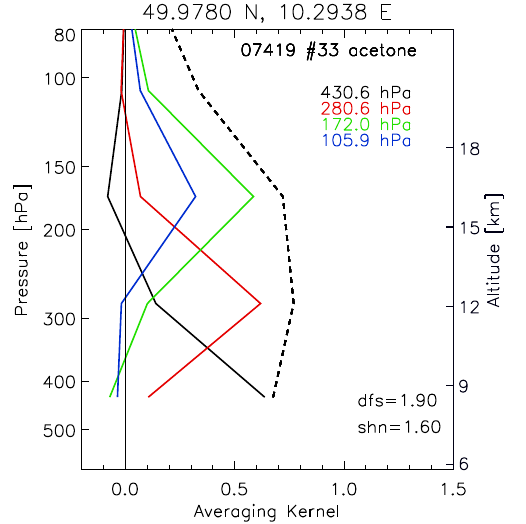
Fig. 3. A representative averaging kernel in log(VMR) for a single mid-latitude acetone retrieval from orbit 07419, scan number 33 (1 August 2003, 50.0 ◦ N, 10.3 ◦ E). There are 1.9 degrees of freedom for these measurements. For this particular scan, the measurements have 1.6 bits of Shannon information content. The dashed black line represents the sum of the averaging kernel at each altitude.